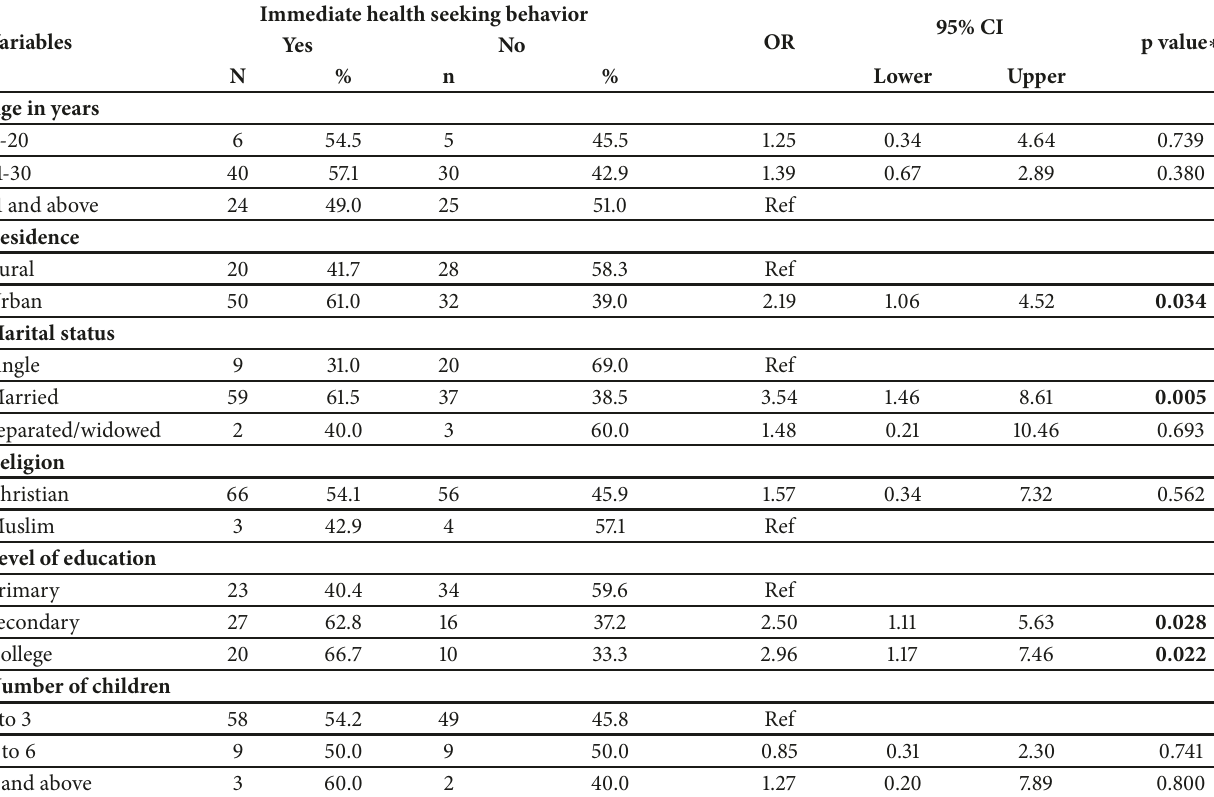
Table 3: Relationship between sociodemographic characteristics and health seeking among the respondents.